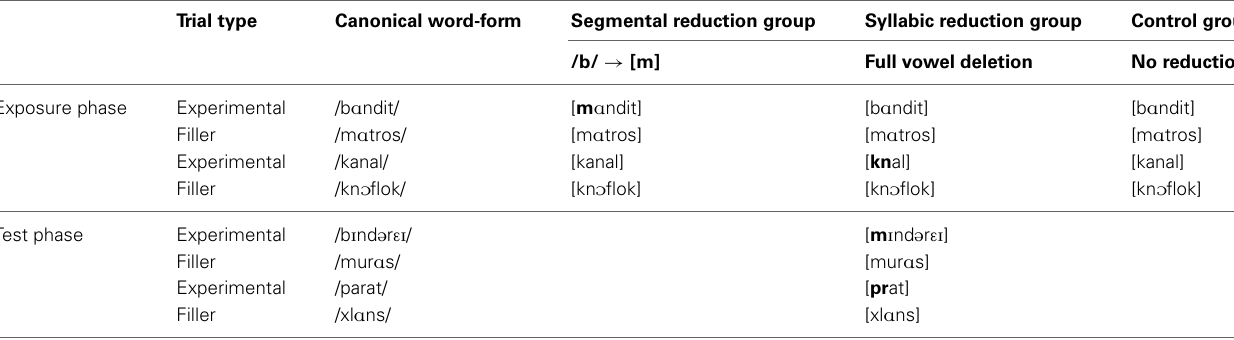
Table 3 | Experimental design and types of stimuli in Experiment